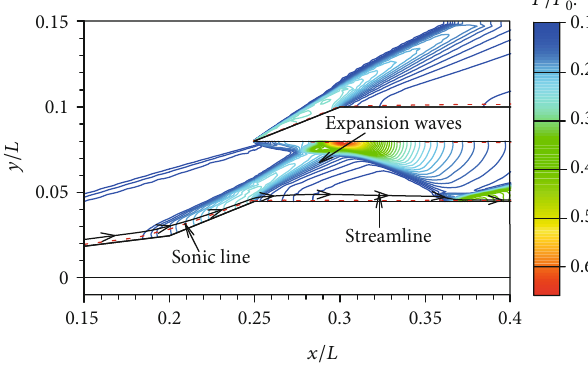
Figure 21: Flow fi eld structure in hypersonic inlet with MHD control ( B = 3 : 0 T max